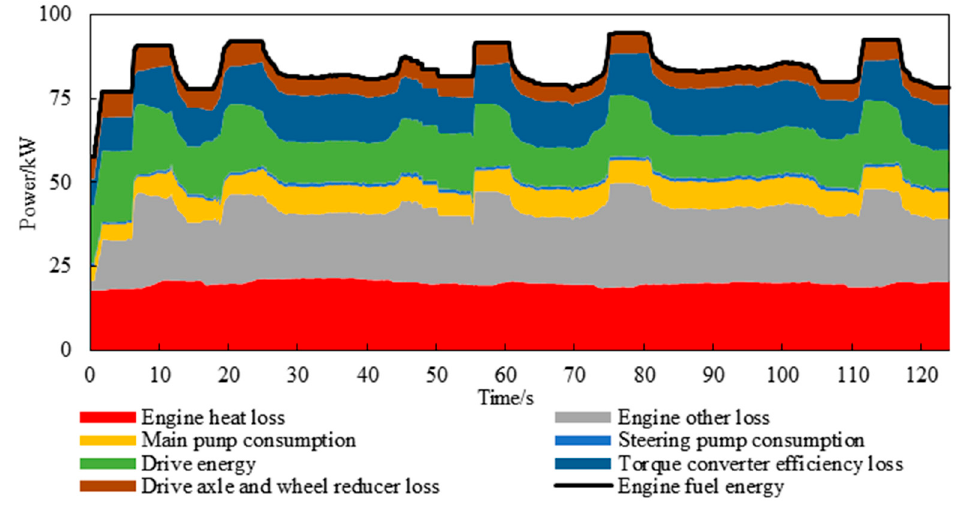
Figure 24. Transportation condition energy flow.